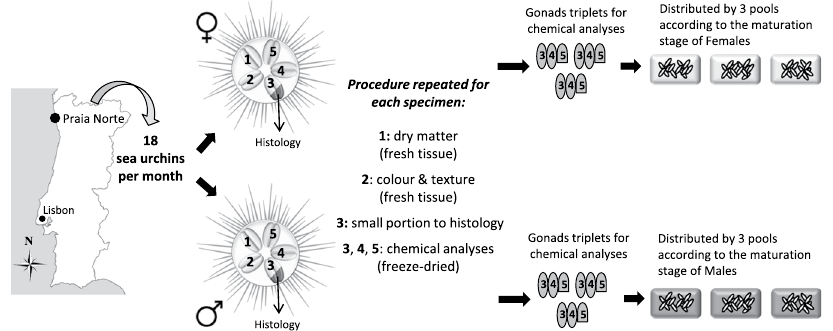
Figure 5. Summary of the monthly sampling protocol performed for P . lividus at Praia Norte (Portugal) over a 13-month